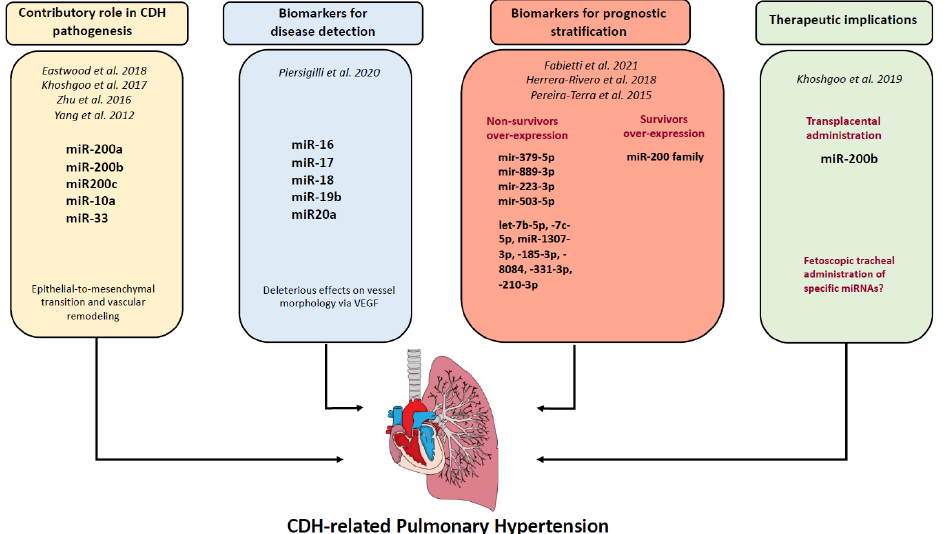
Figure 1. Representative diagram of the multiple roles of miRNAs for CDH-related PH. References [15–23] are cited in this